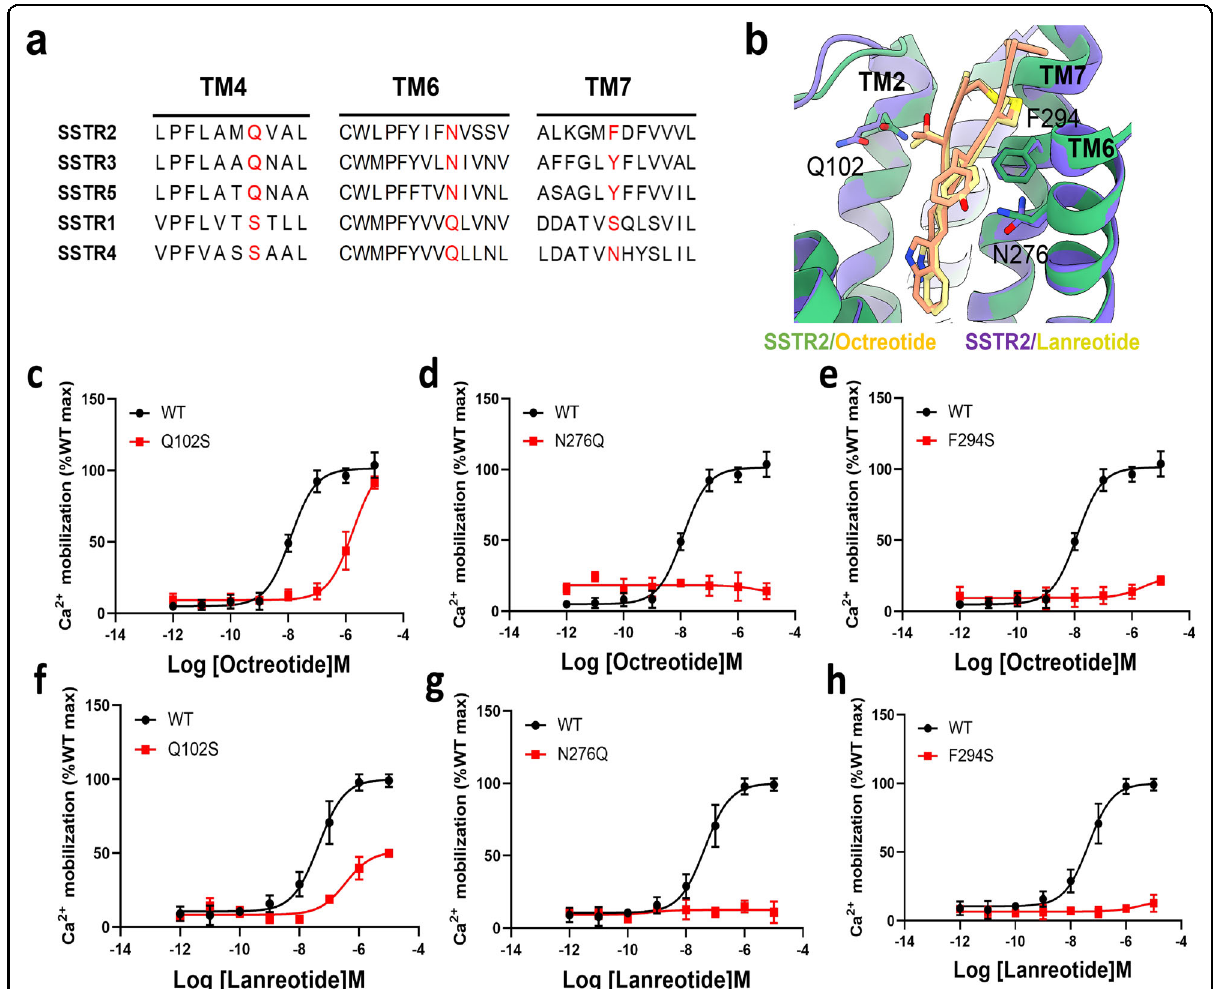
Fig. 5 Structural and functional presentation of subtype-selective site of SSTR2. a Local sequence alignment of TM2, TM6, and TM7 of SSTR family. b Amino acid sites that may be associated with SSTR2 subtype selectivity are shown in the binding pockets of octreotide and lanreotide. c – e Ca 2 + accumulation analysis of wild-type (WT) SSTR2 and mutants with octreotide. Site mutations to the corresponding amino acids of SSTR1 disrupted the receptor – ligand interactions, resulting in SSTR2 malfunction in the Ca 2 + accumulation assay. Data are presented as means ± SEM of three independent experiments conducted in triplicate. f – h Ca 2 + accumulation analysis of WT SSTR2 and mutants with lanreotide. Mutations to the corresponding amino acids of SSTR1 disrupted the receptor – ligand interactions, resulting in SSTR2 malfunction in the Ca 2 + accumulation assay. Data are presented as means ± SEM of three independent experiments conducted in